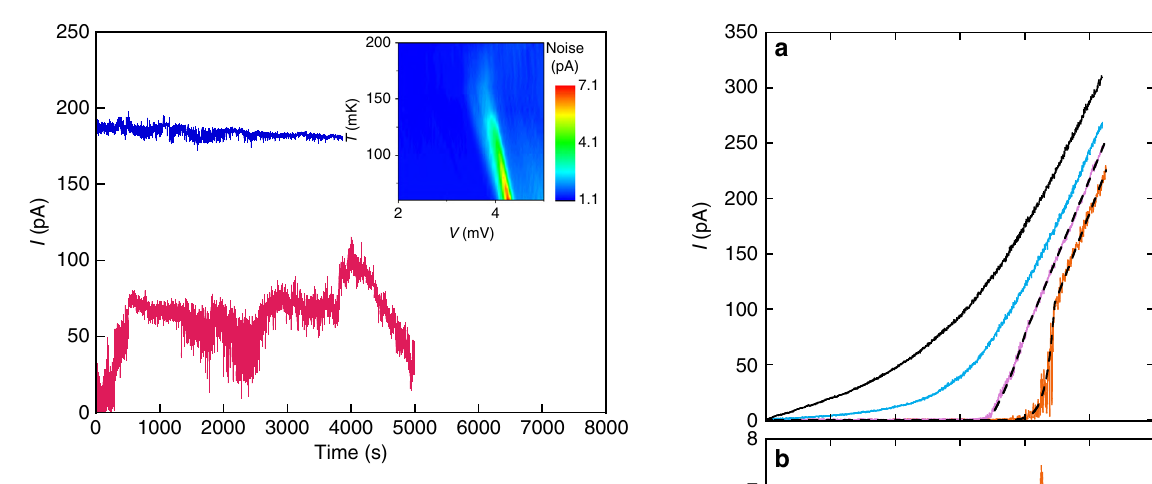
n = 5.36 × 10 10 cm − 2 s